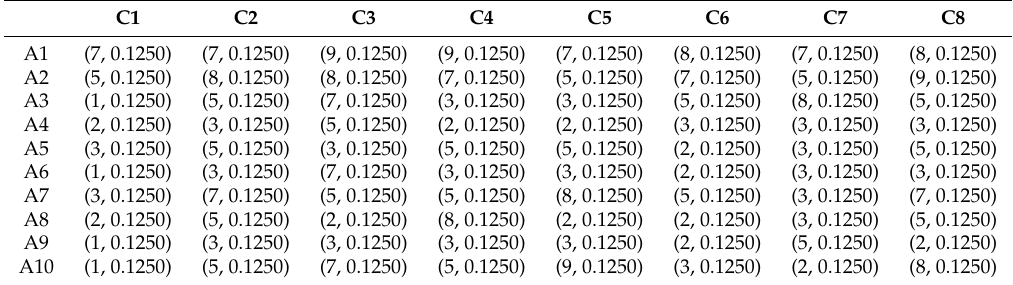
Table 9. The converted evaluation information consider the criteria for each quality goal.